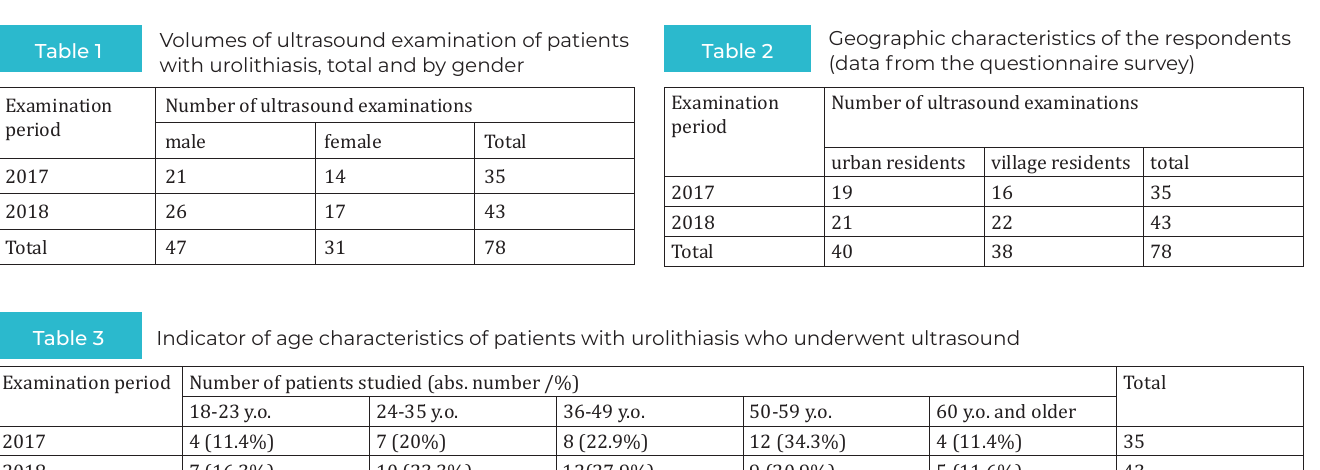
Examination period Number of patients studied (abs. number